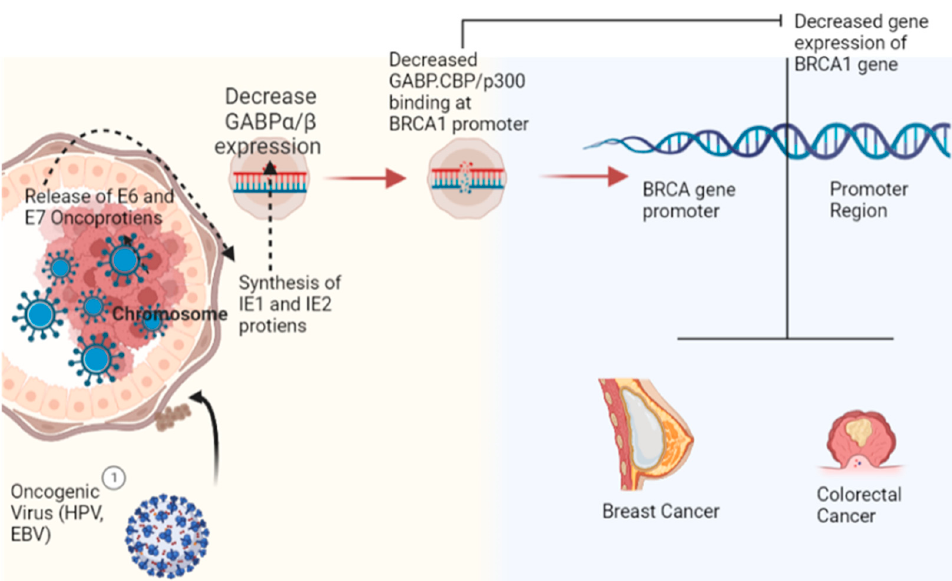
Figure 1. Role of viral oncogenic proteins in the progression of the most common type of cancers (breast cancer and colorectal cancer) with particular emphasis on the BRCA1 gene (Image created by biorender.com, accessed on 2 November 2022).